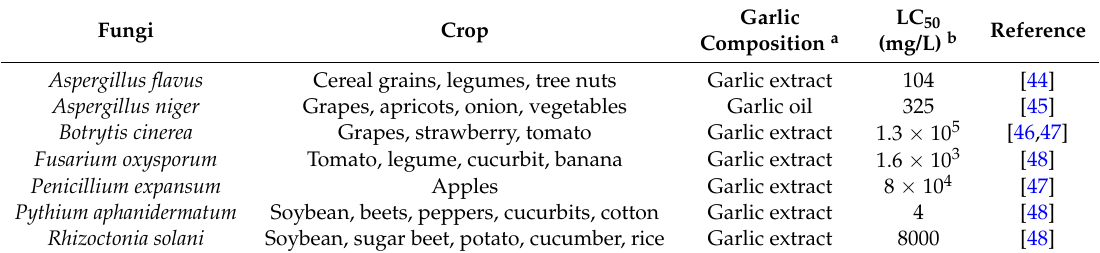
Table 3. Efficacy of different garlic compositions on a range of plant pathogenic